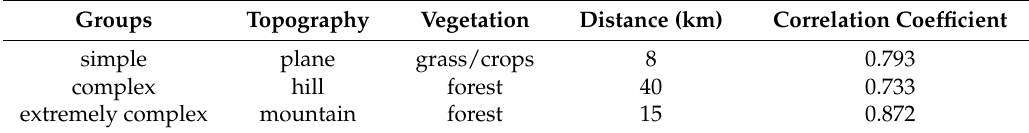
Table 4. Topography, distance, and correlation coefficient of the classes.